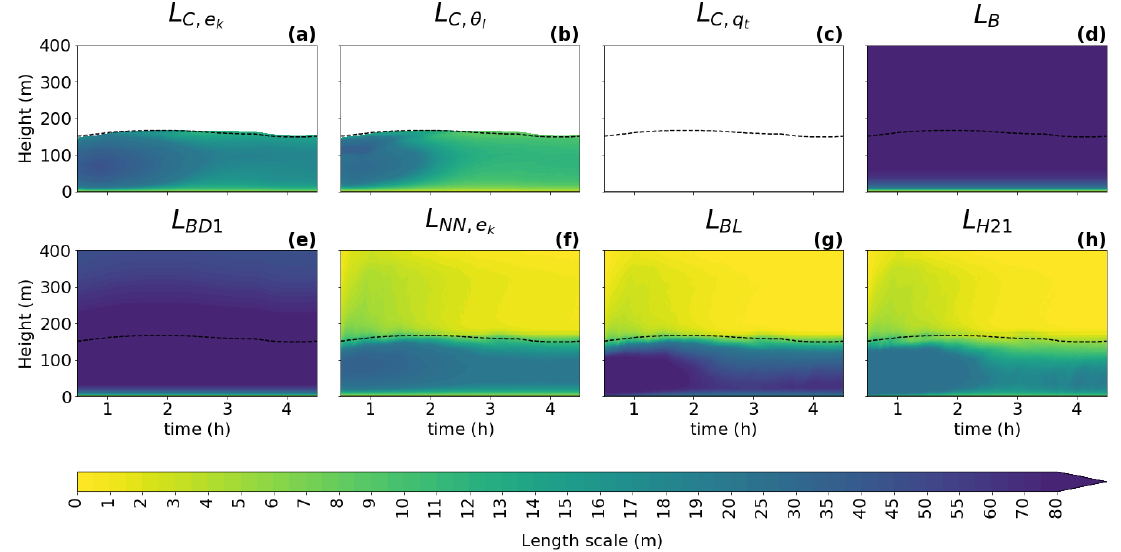
Figure 7. Same content as Figure 3, but for the GABLS1 case. L C , q